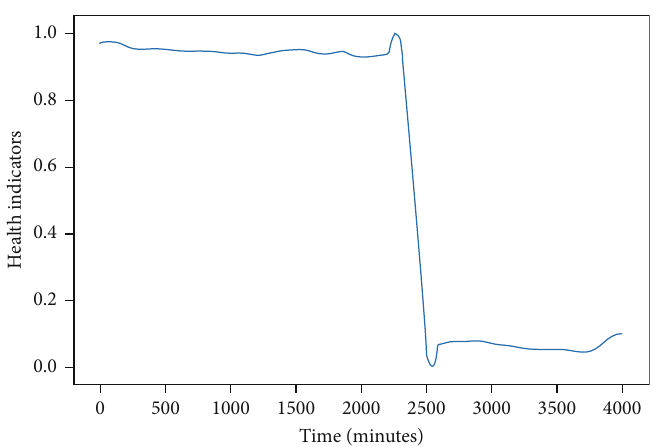
Figure 9: HI curve of tubing broken.